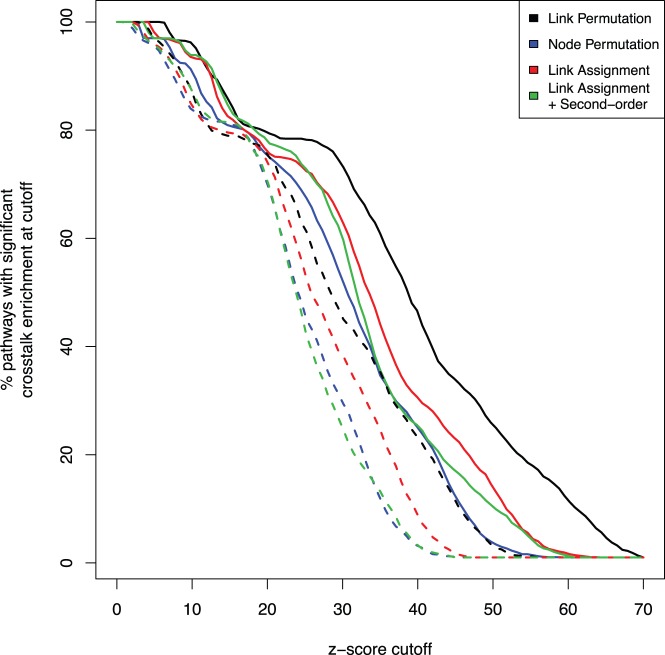
Comparison of the false negative rate for the four different methods.Shown is the percentage of correctly recovered pathways (i.e. 1– false negative rate) as a function of the z-score. Solid lines represent internal crosstalk enrichment detection rates while dashed lines represent inter-crosstalk enrichment detection rates for KEGG pathways that were split into random halves. The test was performed using KEGG pathways mapped to the FunCoup network.